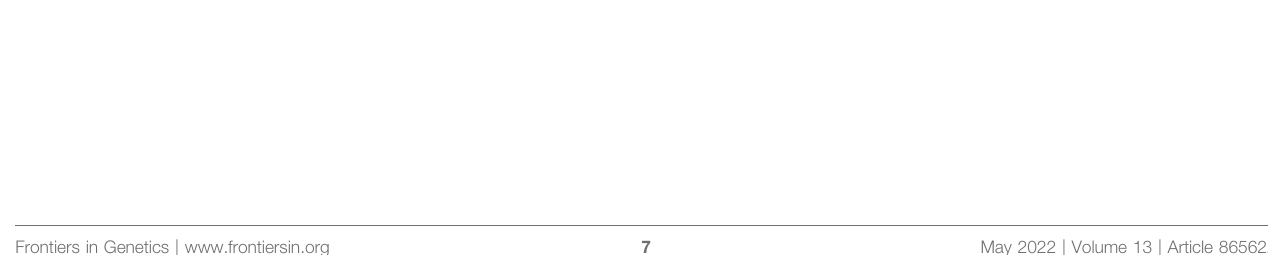
Frontiers in Genetics |